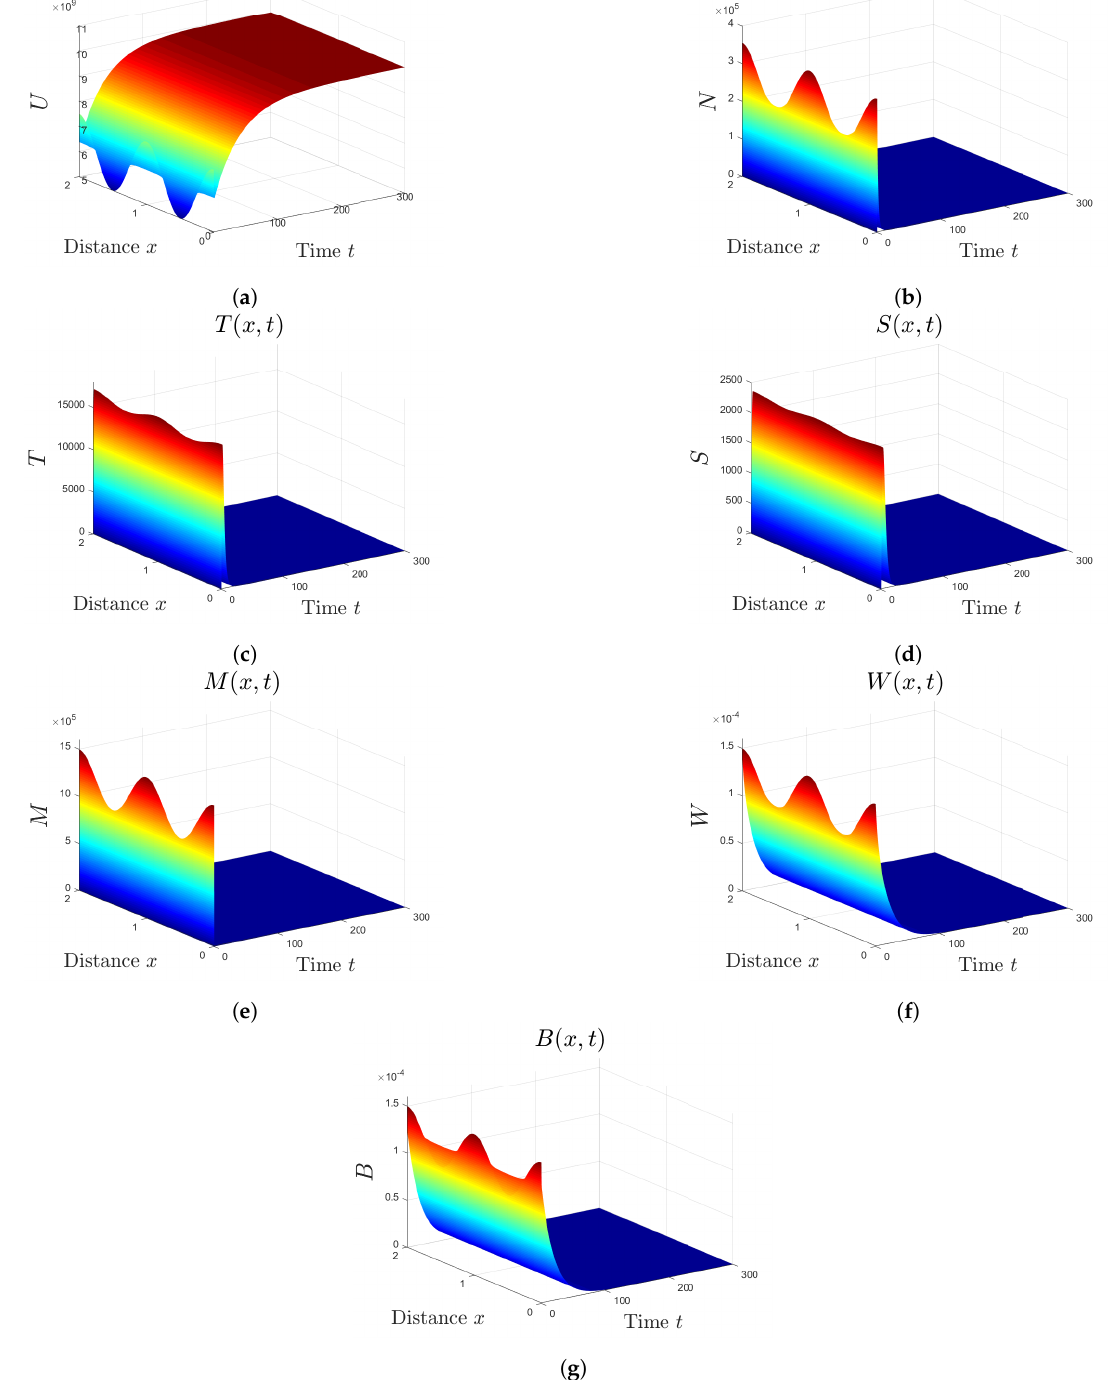
Figure 1. The numerical simulations of model (3) when R i ≤ 1. The disease-free equilibrium E 0 is globally asymptotically stable. The subfigures show the spatiotemporal behaviors of ( a ) uninfected red blood cells U , ( b ) ring infected red blood cells N , ( c ) trophozoite infected red blood cells T , ( d ) schizont infected red blood cells S , ( e ) free merozoites M , ( f ) CTLs W , and ( g ) antibodies B